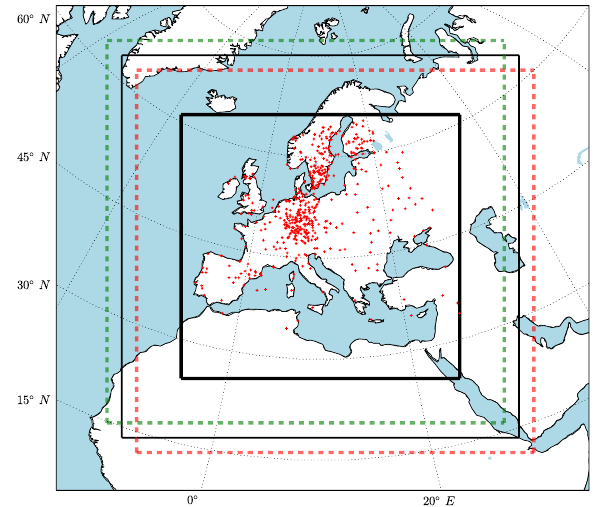
Figure 1. RCM domains: the thin black box shows the nature and the dashed boxes show the shifted members (only two are shown for the northwest and southeast with five grid points of distance from nature). The red pluses show 500 random meteorological stations of the “ENSEMBLES daily gridded observational dataset for precipi- tation, temperature and sea level pressure in Europe called E-OBS” (Haylock et al., 2008). The thick black box shows the evaluation